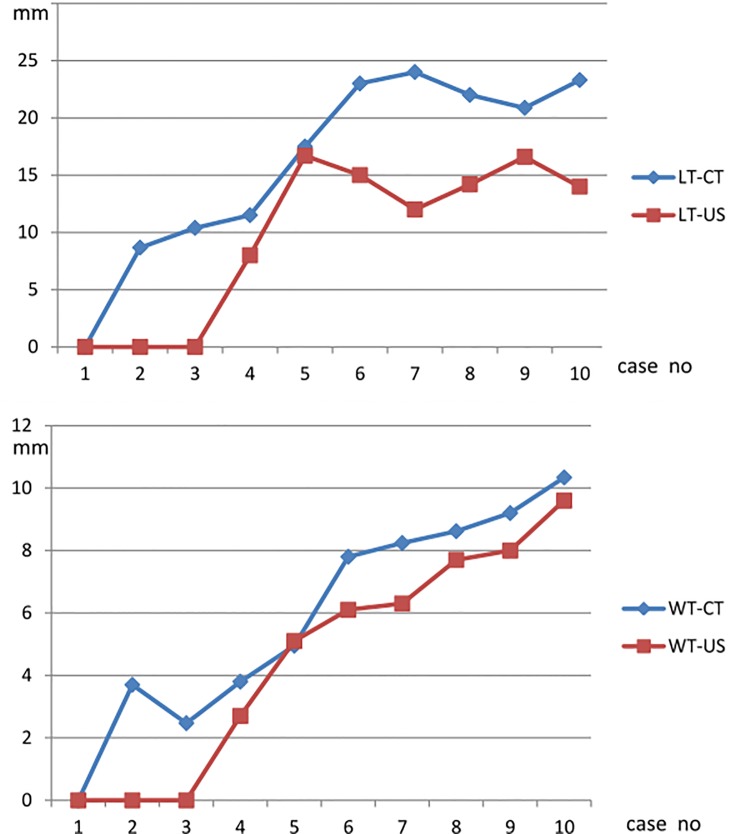
Validation for nodal length values measured by ultrasound (LT-US) with computed tomography (LT-CT).Validation for nodal width values measured by ultrasound (WT-US) with computed tomography (WT-CT).